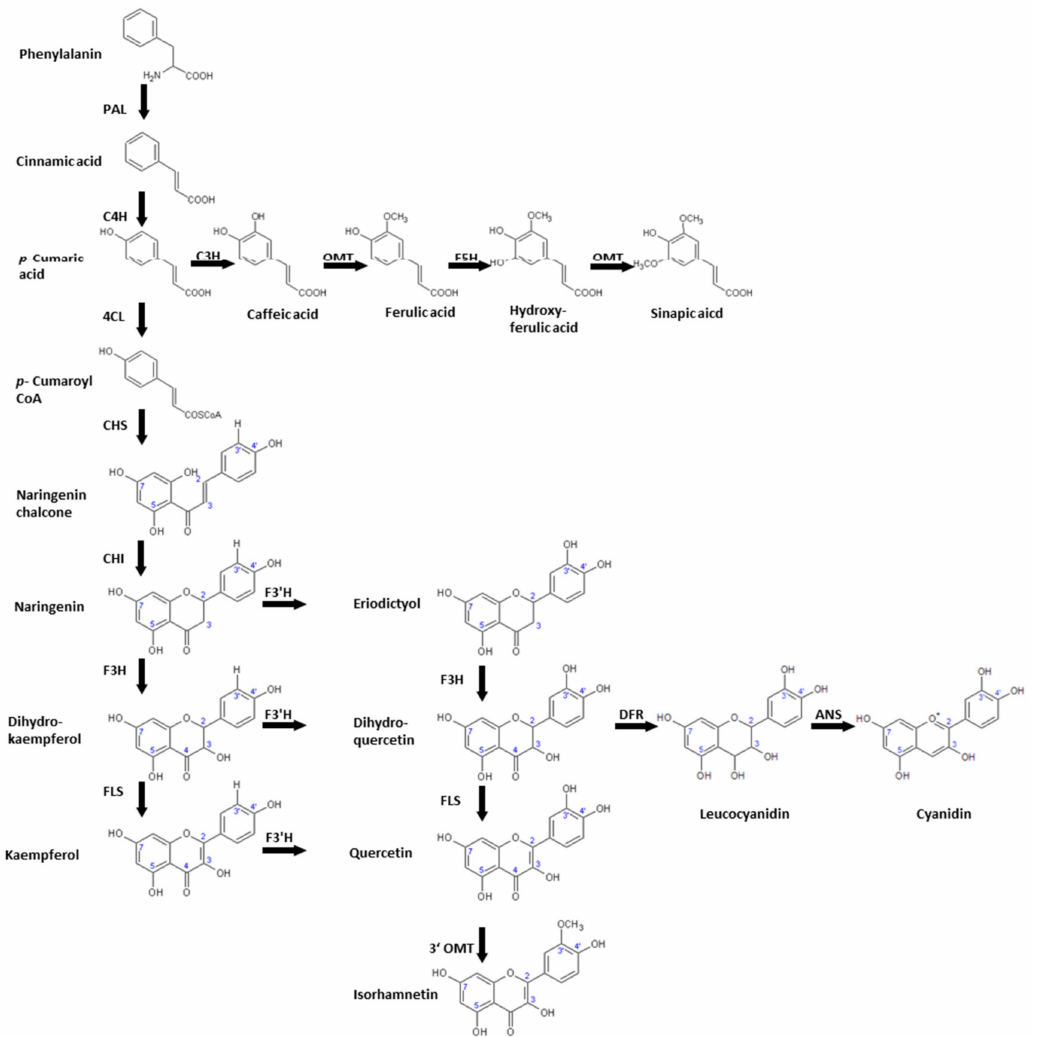
Figure 3. Biosynthesis of phenylpropanoids relevant to Brassica species including the involved enzymes PAL: phenylalanine ammonia-lyase, C4H: cinnamic acid 4-hydroxylase, C3H: p-coumaric acid 3-hydroxylase, OMT: O -methyltransferase, F5H: ferulic acid 5-hydroxylase, 4CL: 4-Coumaroyl CoA-Ligase CHS: chalcone synthase, CHI: chalcone isomerase, F3H: flavanone 3 β -hydroxylase, FLS: flavonol synthase, F3 (cid:48) H: flavonol 3 (cid:48) -hydroxylase, 3 (cid:48) OMT: 3 (cid:48) - O -methyltransferase, DFR: dihydroflavonol 4-reductase, ANS: anthocyanin